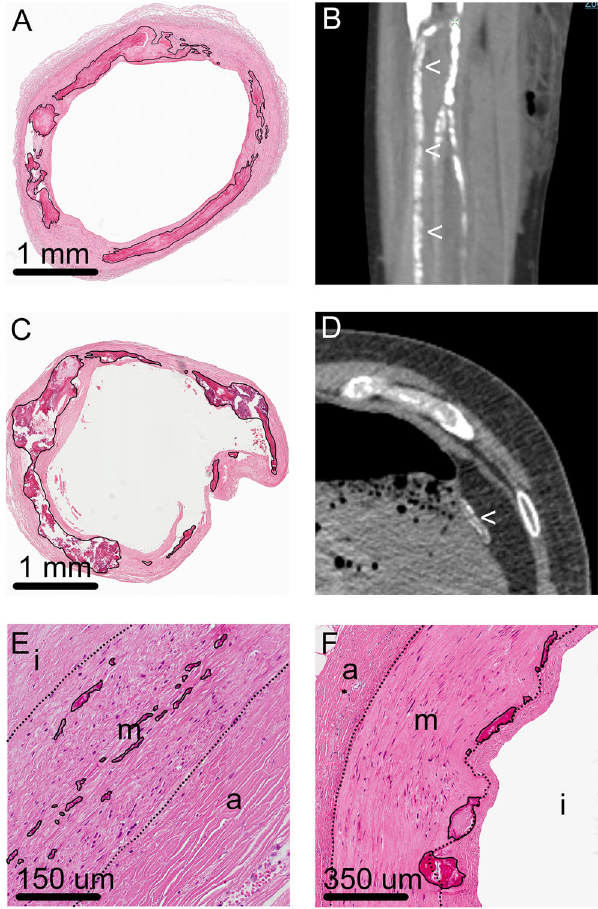
Fig. 3 Vascular calcifications. A and B: Extensive calcifications, on the CT scan seen as more or less circumferential calcifications in a longer segment of the vascular wall, were present around the internal elastic lamina and in the media of the vessels of the lower extremities [here the anterior tibial artery (<)]; calcifications are marked with a black line in A. C and D. The same internal elastic lamina and medial calcifications were visible in the gastroepiploic artery, located along the greater curvature of the stomach, in both the histology (calcifications are marked in C)and CT scan (<). E and F: In most of the other large- and middle-sized arteries, variable amounts of calcified elastic fibres were seen in the media (in elastic arteries) and/or around the internal and external elastic lamina (marked). These small calcifications could not be detected on CT scans, on which also many atherosclerotic intimal calcifications were visible (i = intima, m = media, a = adventitia; dotted lines indicate internal and external elastic lamina)